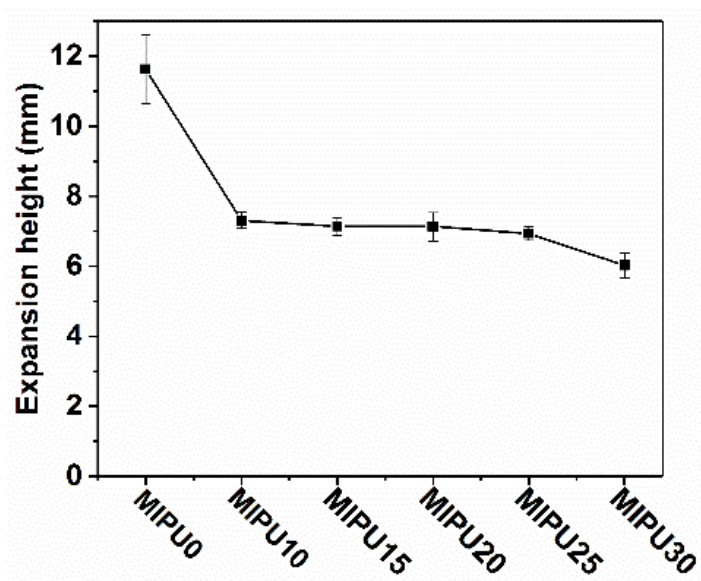
Figure 7. Expansion height of the char of the coatings.